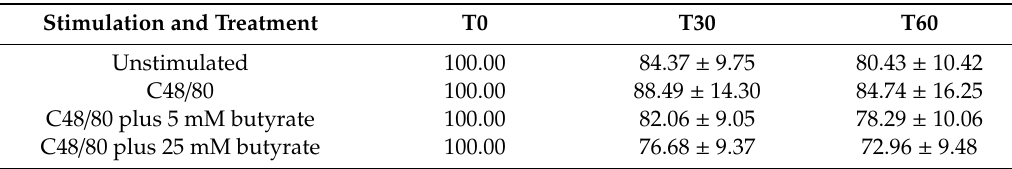
Table 1. Relative transepithelial electrical resistance (TER) values (mean ± s.d.) normalized to baseline (T0).